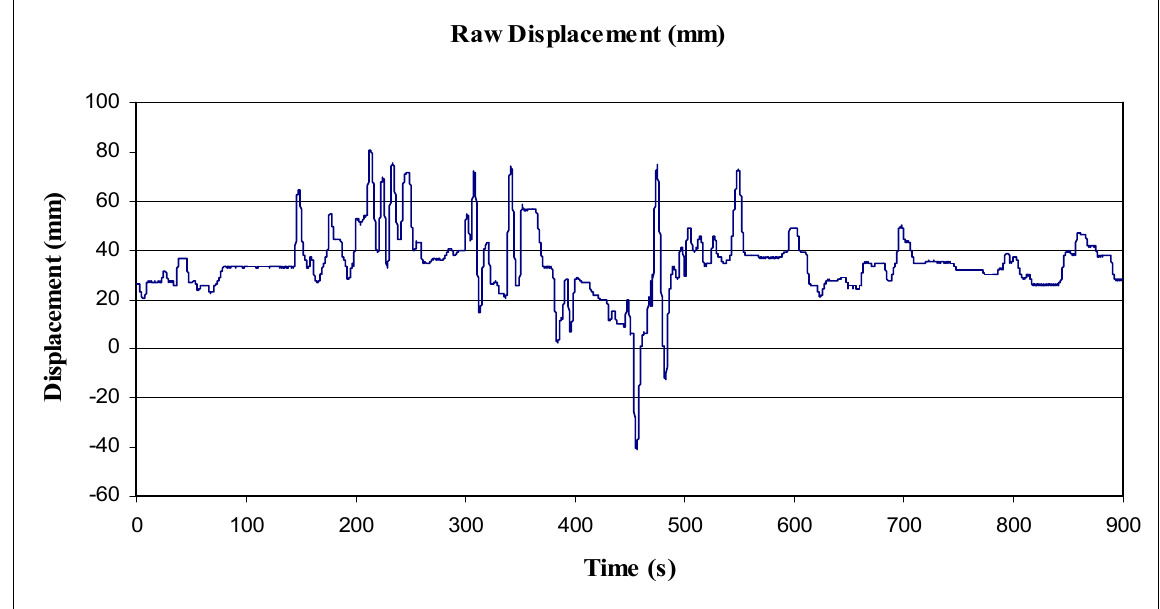
Figure 5. Displacement of suspended mass, versus